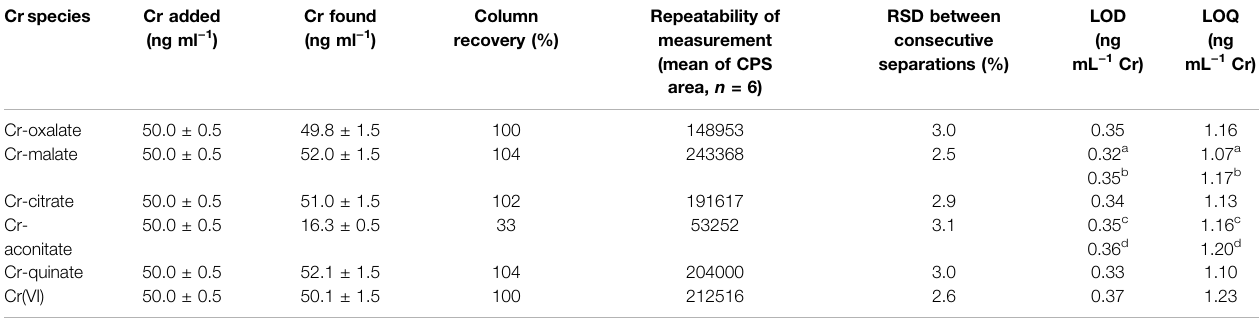
TABLE 1 | Column recoveries, repeatability of measurements based on mean of CPS area of 6 consecutive separations, LODs and LOQs for Cr-oxalate, Cr-malate, Cr- citrate, Cr-aconitate, and Cr(VI) (Cr concentration 50 ng ml − 1 , pH 6.5) by the HPLC-ICP-MS procedure.